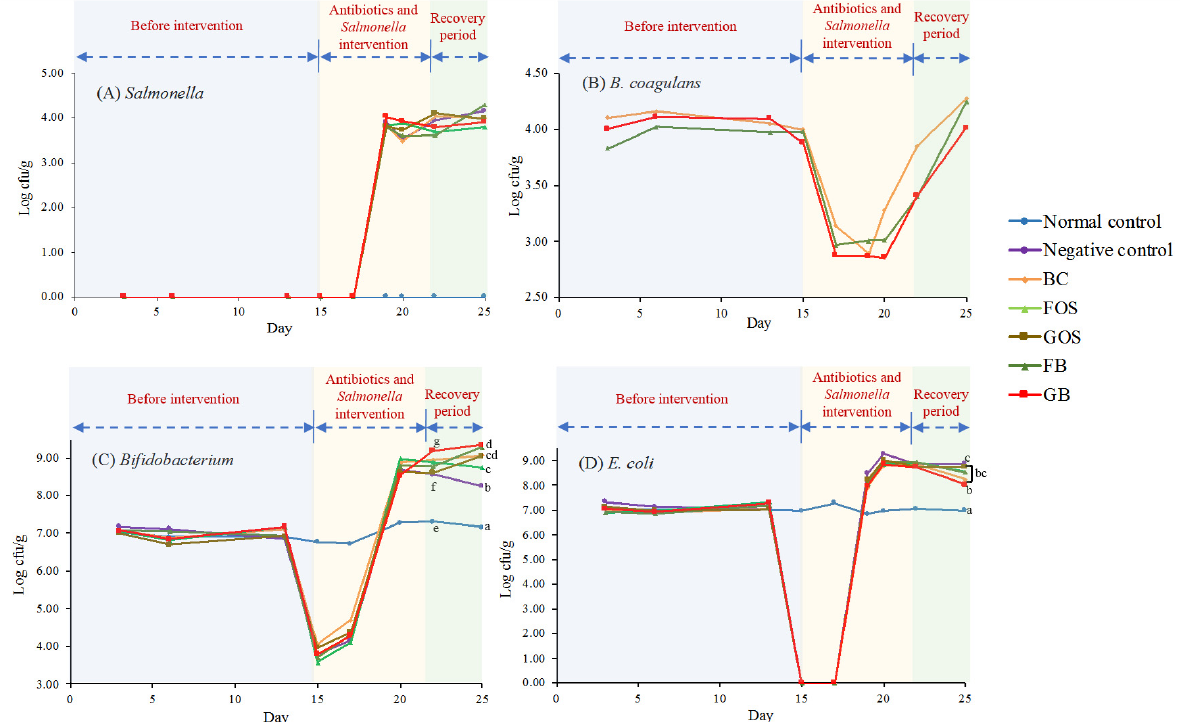
Figure 5. Change in different fecal bacteria counts (Log cfu/g) among different animal groups. ( A ) fecal Salmonella ; ( B ) fecal B. coagulans ; ( C ) fecal Bifidobacterium spp.; ( D ) fecal Escherichia coli. Blue zone (days 0 to 14) indicates the period before intervention. Yellow zone (days 15 to 22) indicates the period of antibiotics intervention and Salmonella infection. Green zone (days 23 to 25) indicates the recovery period. Mean values on the curves bearing different letters (e–g) indicate significant differences ( p < 0.05) among different groups on day 22. Mean values on the curves bearing different letters (a–d) indicate significant differences ( p < 0.05) among different groups on day 25.